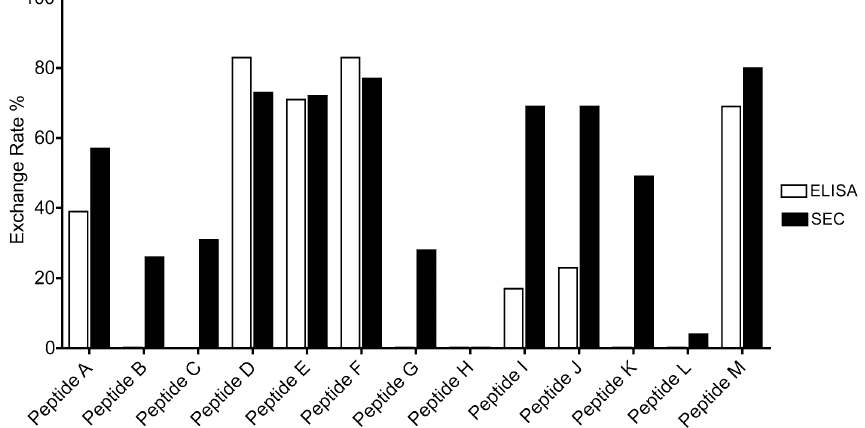
Figure 5. Peptide exchange screening. Comparison of the two quantification methods, ELISA and SEC. The HLA-E/pUV G2 photosensitive monomer was exposed for 1 h at 355 nm in the presence of 13 different peptides. Exchange rate was calculated as described in Methods